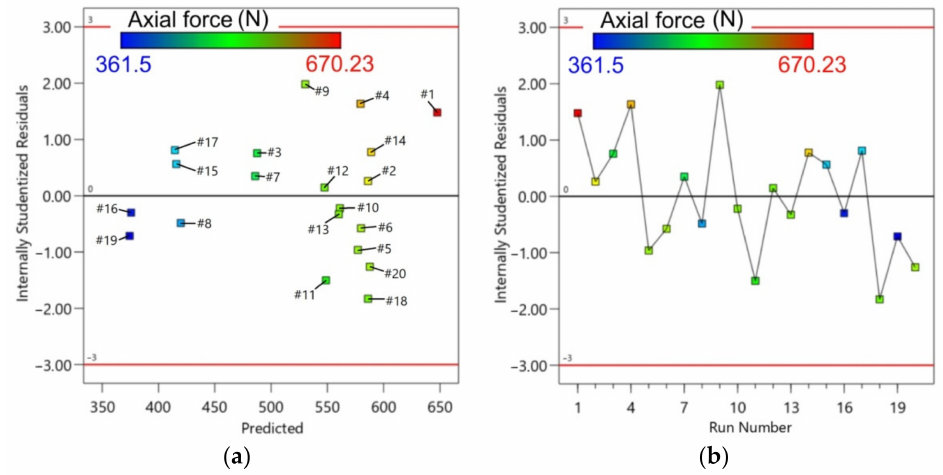
Figure 8. Residuals with reference to: ( a ) predicted; and ( b ) run number for axial forming force.